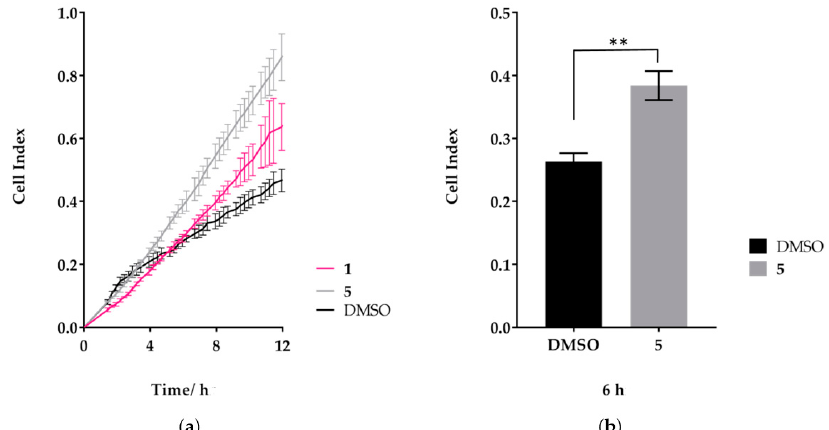
Figure 7. Kinetics of migration in drug-treated MDA-MB-231 cells. Cell migration in real time was analysed by the xCELLigence RTCA. ( a ) Shows the average cell indexes over 12 h for each drug treatment, ( b ) cell migration analysis at 6 h, data shown as mean ± SD of quadruplicate wells and are representative of three independent experiments ( n = 3); ** p ≤ 0.01.